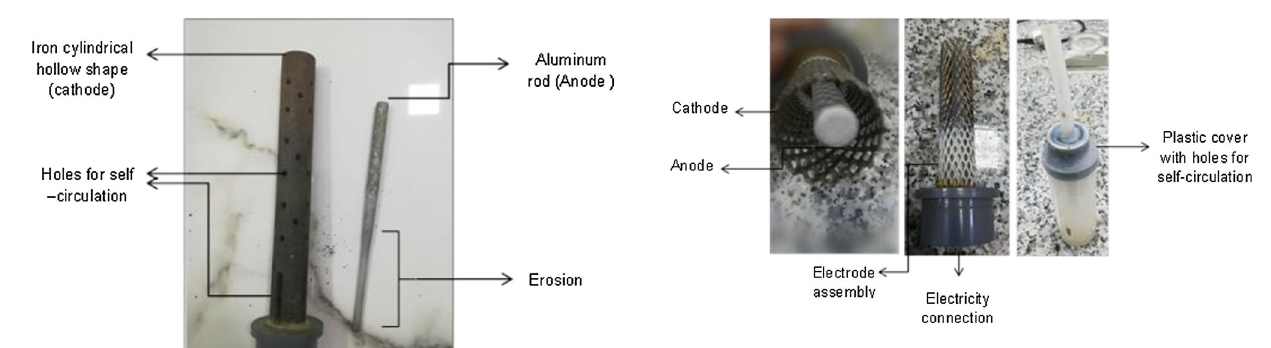
Fig. 3 Schematic diagram of EO